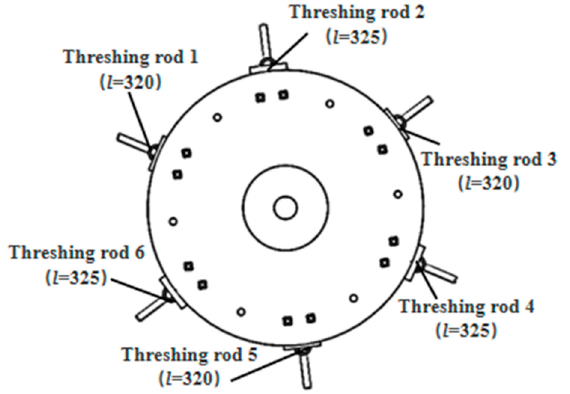
Figure 2. Schematic diagram of the multi-threshing gaps and the threshing rods 1–6.